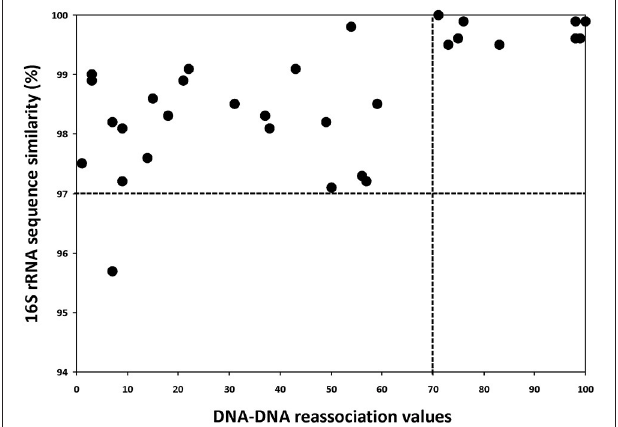
FIGURE 5 | Graph of the 16S rRNA gene sequence similarity vs. DDH relatedness values for the genus Halorubrum . The vertical dashed line indicates the 70% DDH threshold, while the horizontal dashed line indicates 97% 16S rRNA gene sequence similarity.